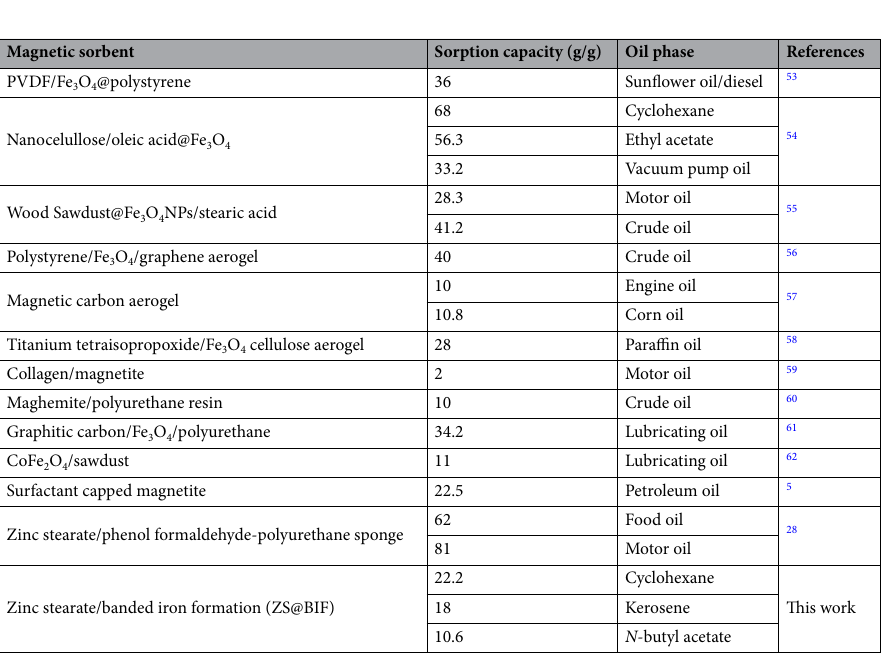
Table 2. Comparison of the adsorption capacity for the currently developed sorbent with that of previously reported magnetic hydrophobic composites.